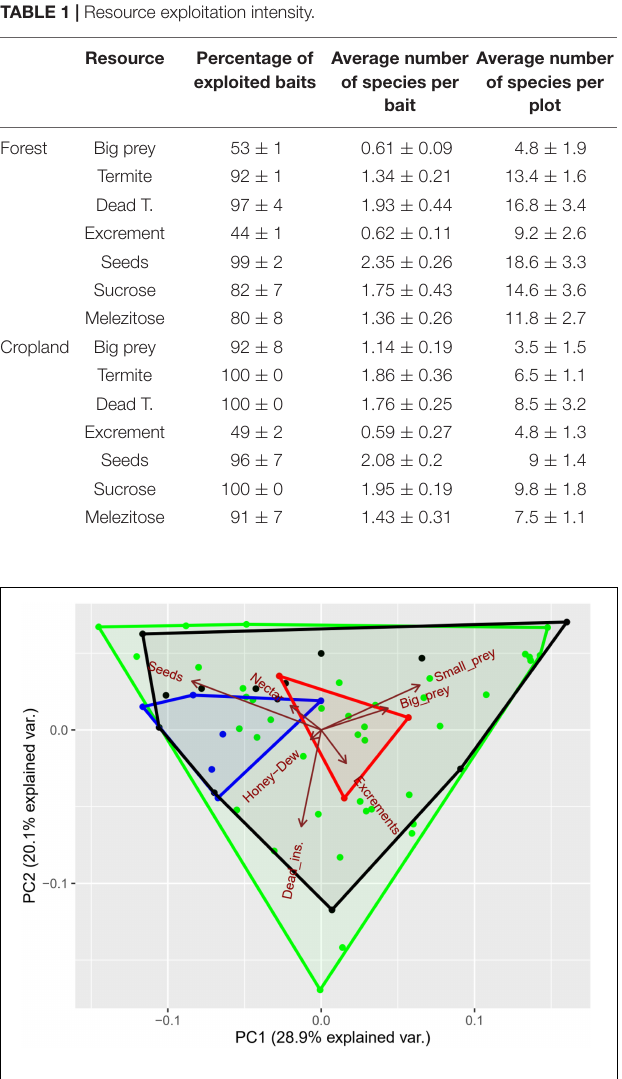
FIGURE 3 | Principal Component Analysis of the trophic niche space. The first and second axes represent the 28.9% and 20% of the variance, respectively. Dots and crosses correspond to forest and cropland species, respectively, distributed along resource axes. Convex hulls encompass four groups of species: in red and blue are dominant species in croplands and forests, respectively. In black and green are the remaining species for croplands and forests. The food types are indicated as follows: termites (Small), mealworms (Large), excrements (Excrements), dead mealworms (Dead), melezitose (Honey-dew), sugar (Nectar), and